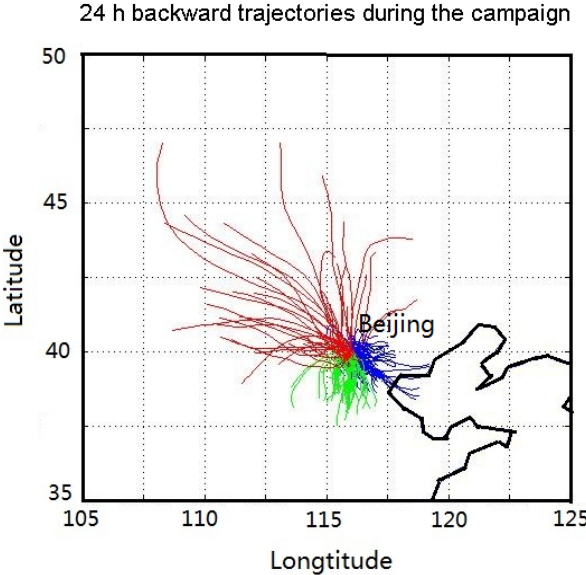
Fig. 3. 24-h Air mass backward trajectories at 10m above ground level at Beijing from 1 August to 15 September 2008. The red, green and blue trajectories show the plumes from north, south and southeast regions.